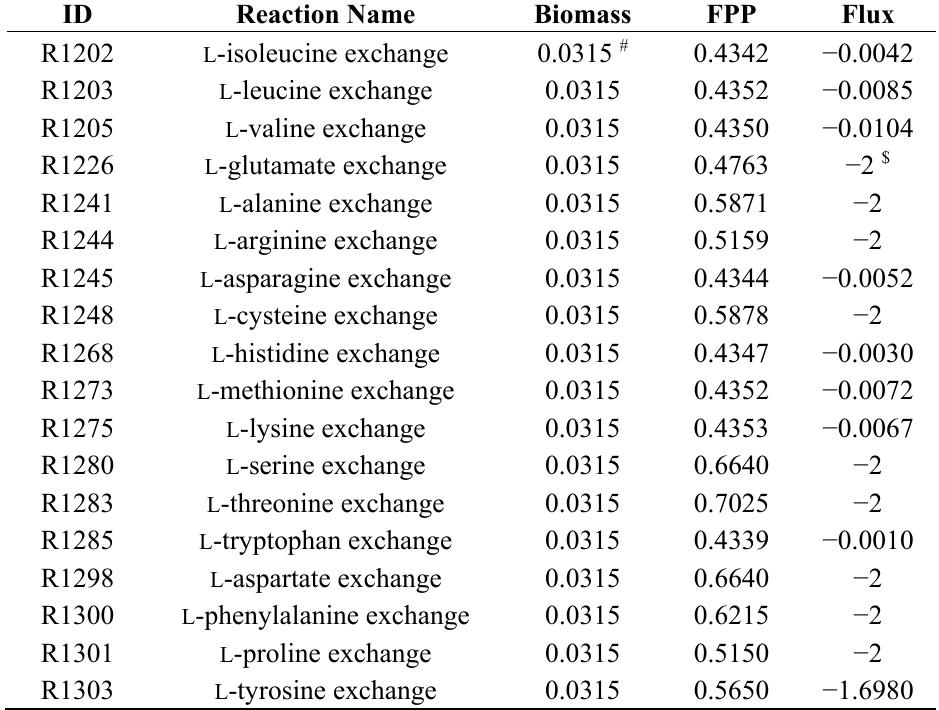
Table 2. Fluxes (mmol/g DCW/h) of 18 exchange reactions of amino acids and their respective effects on FPP production.